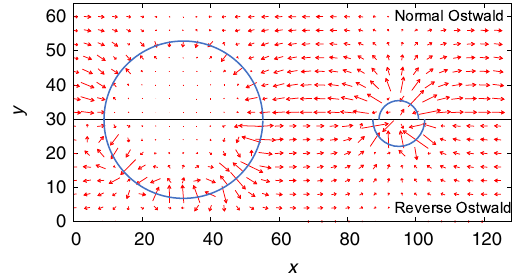
FIG. 6. Snapshots of the total current J for the two droplet simulations shown in Fig. 4(b) at short time t ¼ 1000 . The top half corresponds to regime A or normal Ostwald ( ζ ¼ − 0 . 8 , λ ¼ − 0 . 4 ), and the bottom half corresponds to regime B or reverse Ostwald ( ζ ¼ − 1 . 6 , λ ¼ − 0 . 8 ). (Note that the system is symmetric in y . The arrows are magnified for better visibility; the typical magnitude of J is around 10 − 4